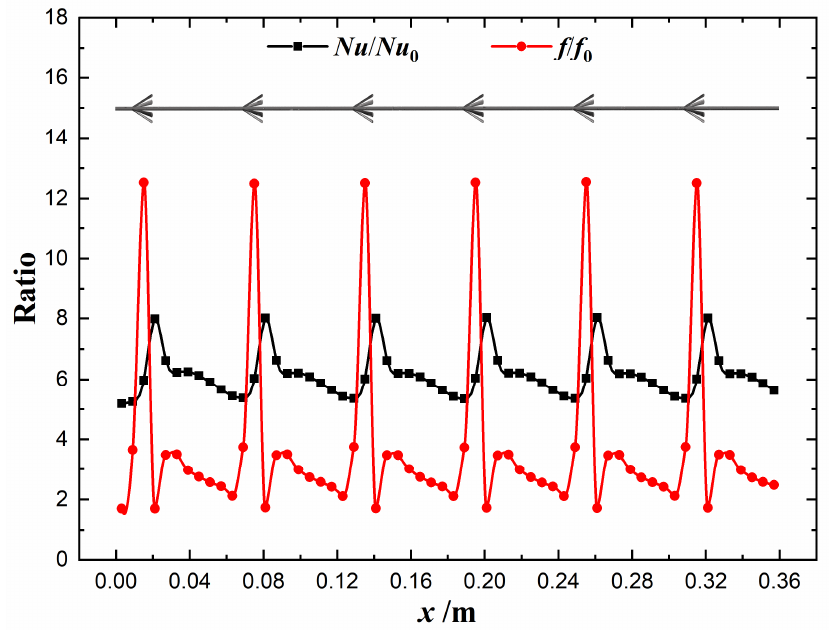
Figure 13. The variation of − Nu / Nu 0 and f / f 0 along the tube at Re = 600.